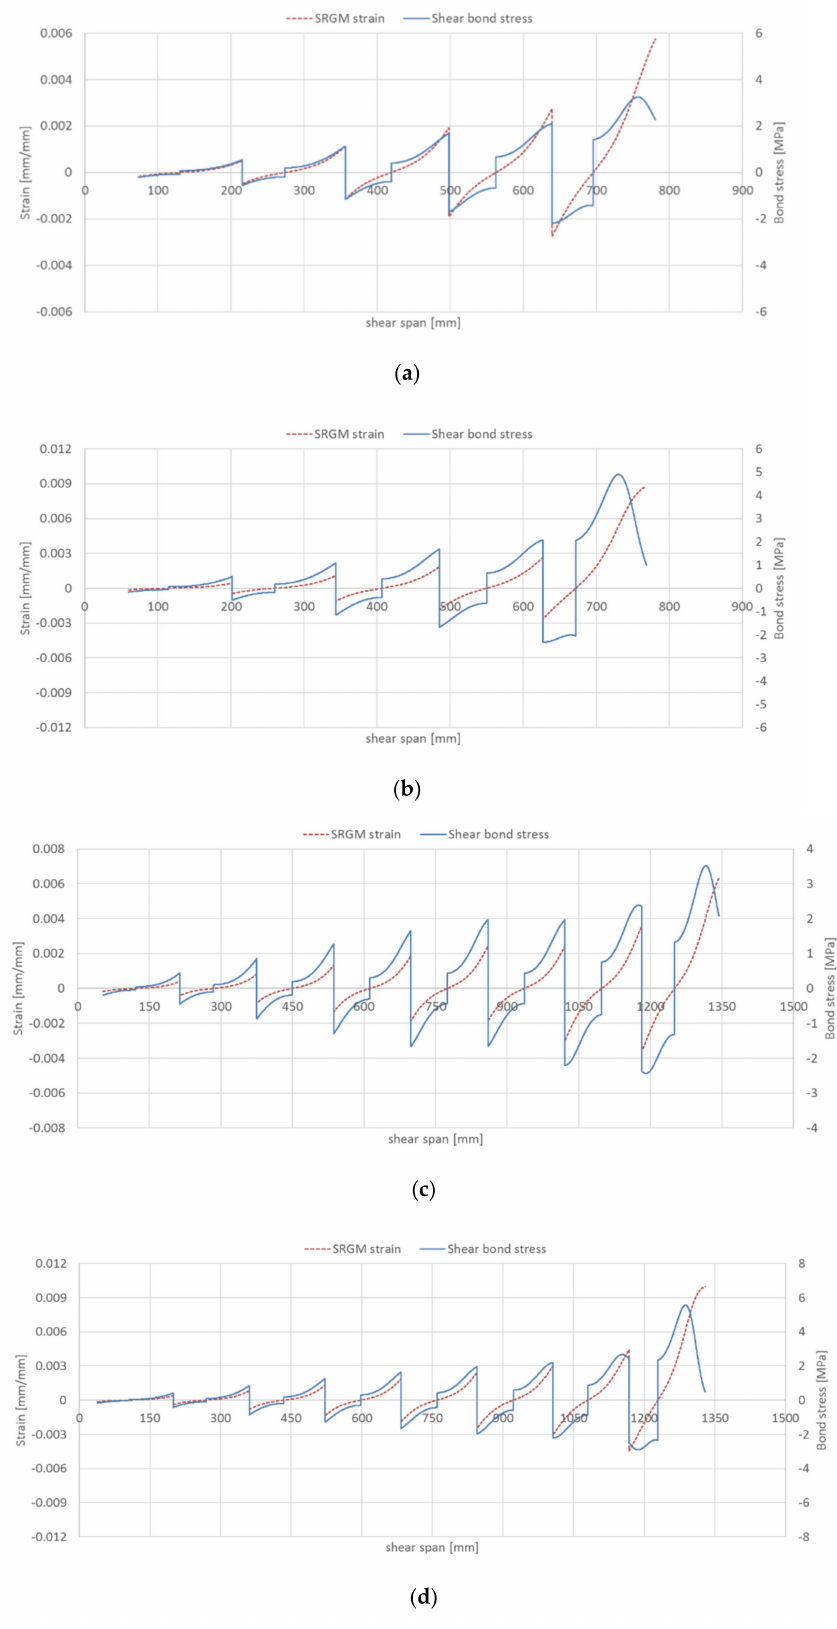
Figure 12. Intermediate debonding prediction at steel strip–matrix interface (shear span): ( a ) beam A-EB; ( b ) beam A-IRS; ( c ) beam B-EB; ( d ) beam